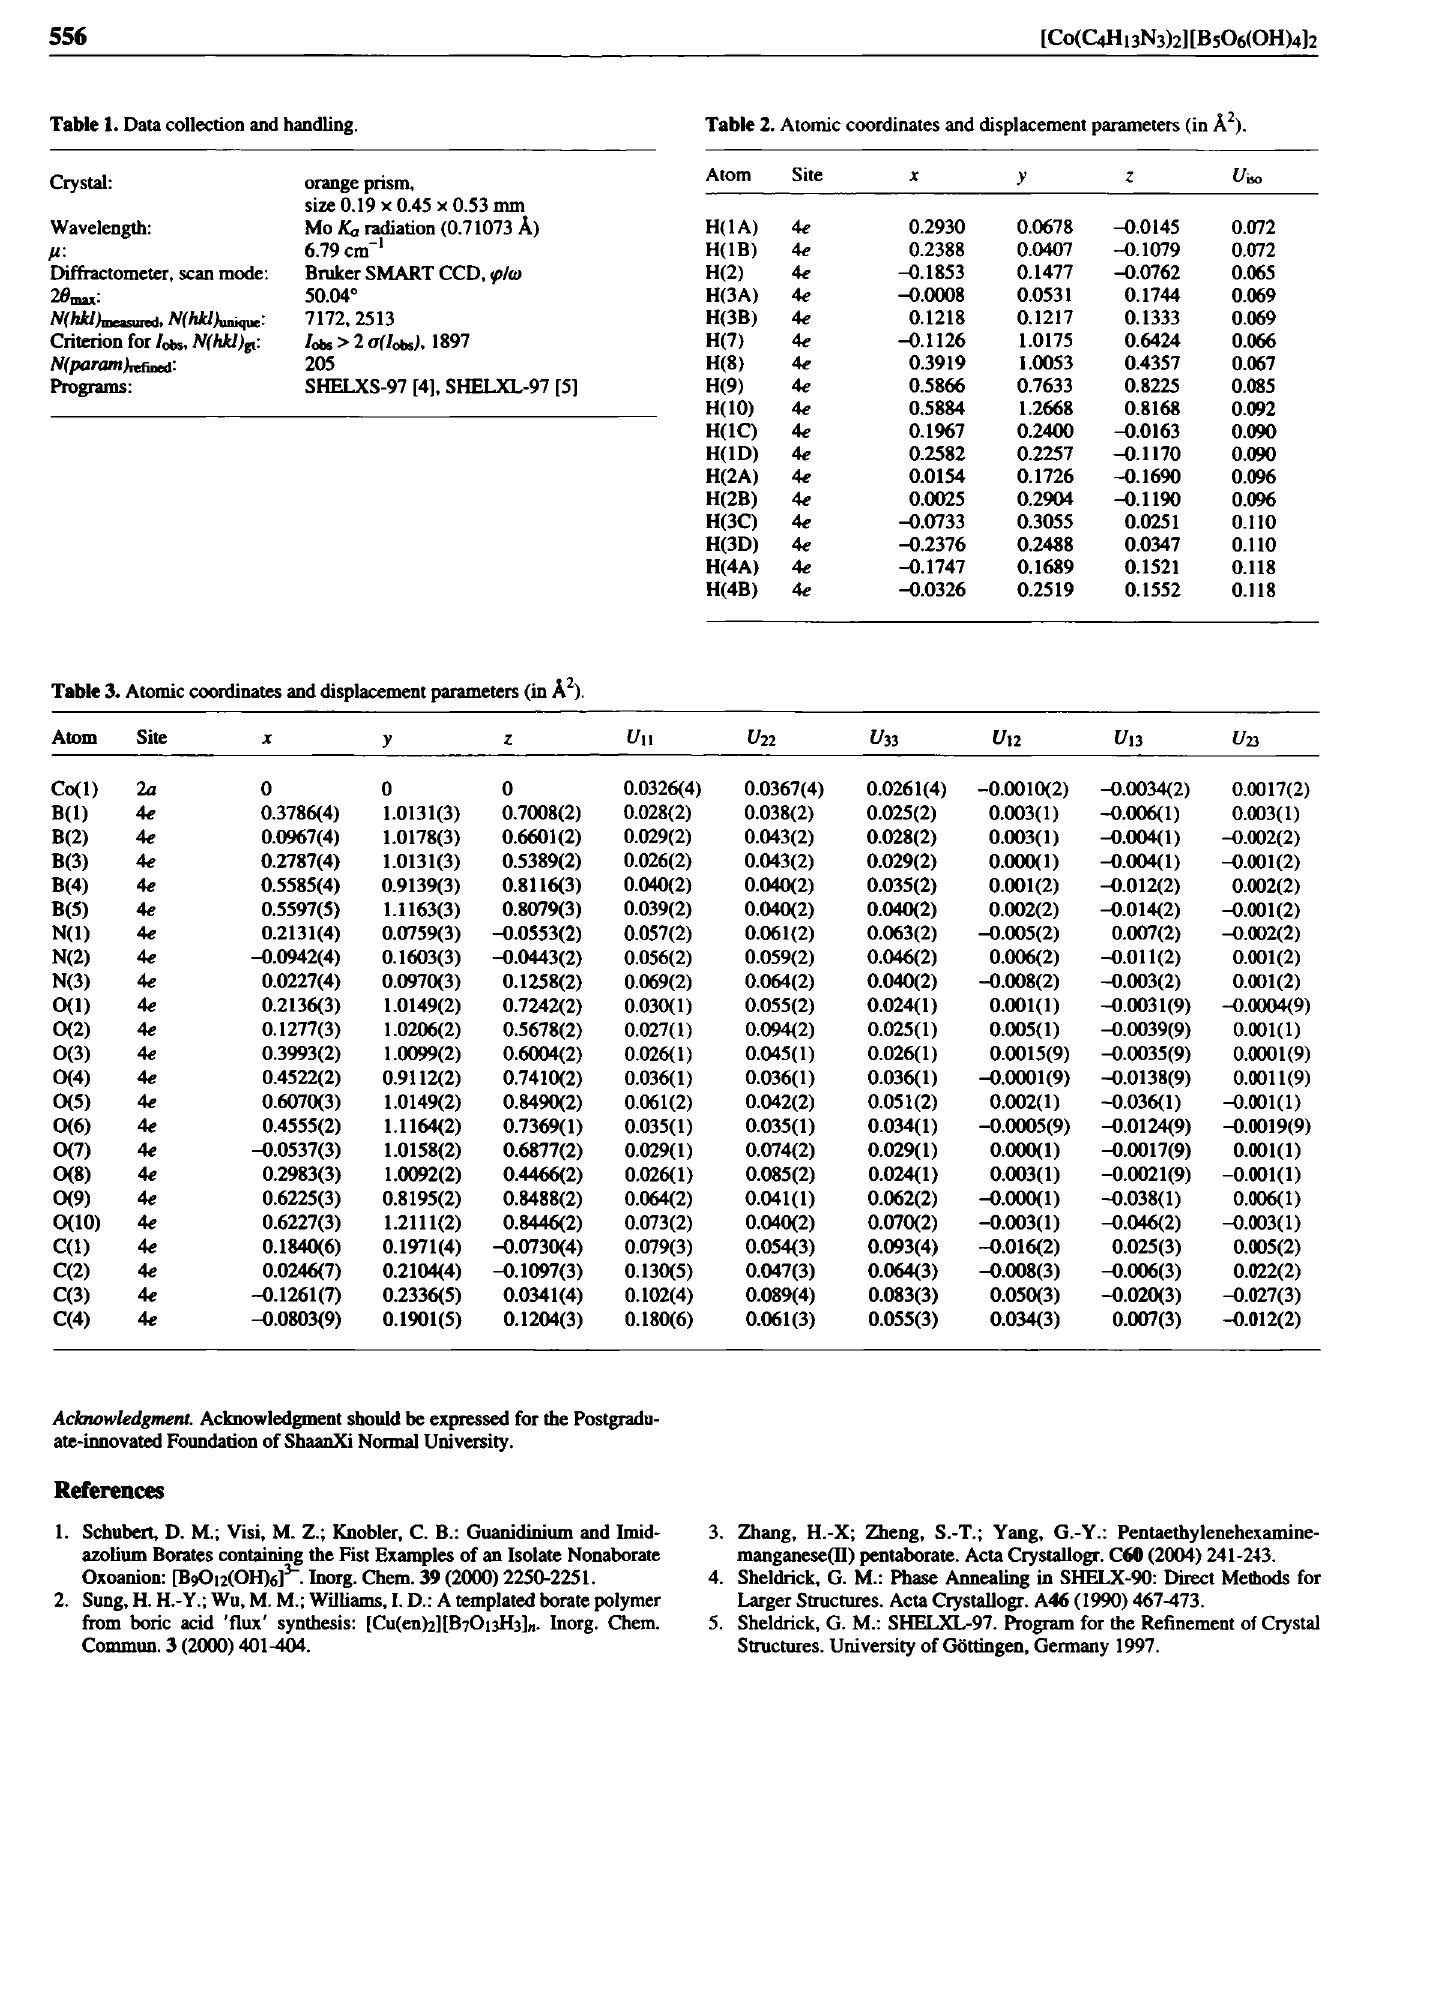
Table 1. Data collection and handling. Table 2. Atomic coordinates and displacement parameters (in Ä 2 ).